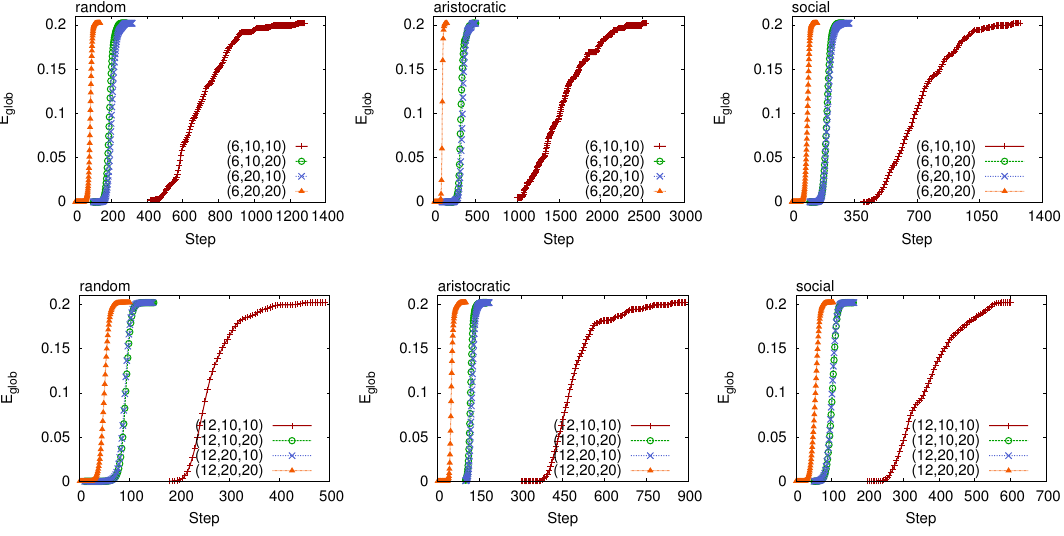
Figure 22. Accelerated analysis with mermaids fixing m = 6 and m = 12, with random, aristocratic, and social rules, preferential model (for mermaids’ dynamics), VirtualTourist online social network. Q3: Trade-off between the benefit of investing on mermaids and the cost . In the plots presented previously, we described how the timespan needed to get the reference efficiency varies according to C s . Figures 23 and 24 (rightmost panels) show T min as a function of C s and this allows to describe more quantitatively the benefit of investing on mermaids. In fact, plots clearly show that this is not linear as one might guess, instead it is inversely proportional as C s . We think this is probably due to the system saturation. In other words, the network is not able to respond to high level of exogenous stimuli from mermaids resulting in performances that are comparatively similar to those obtained with lower cost